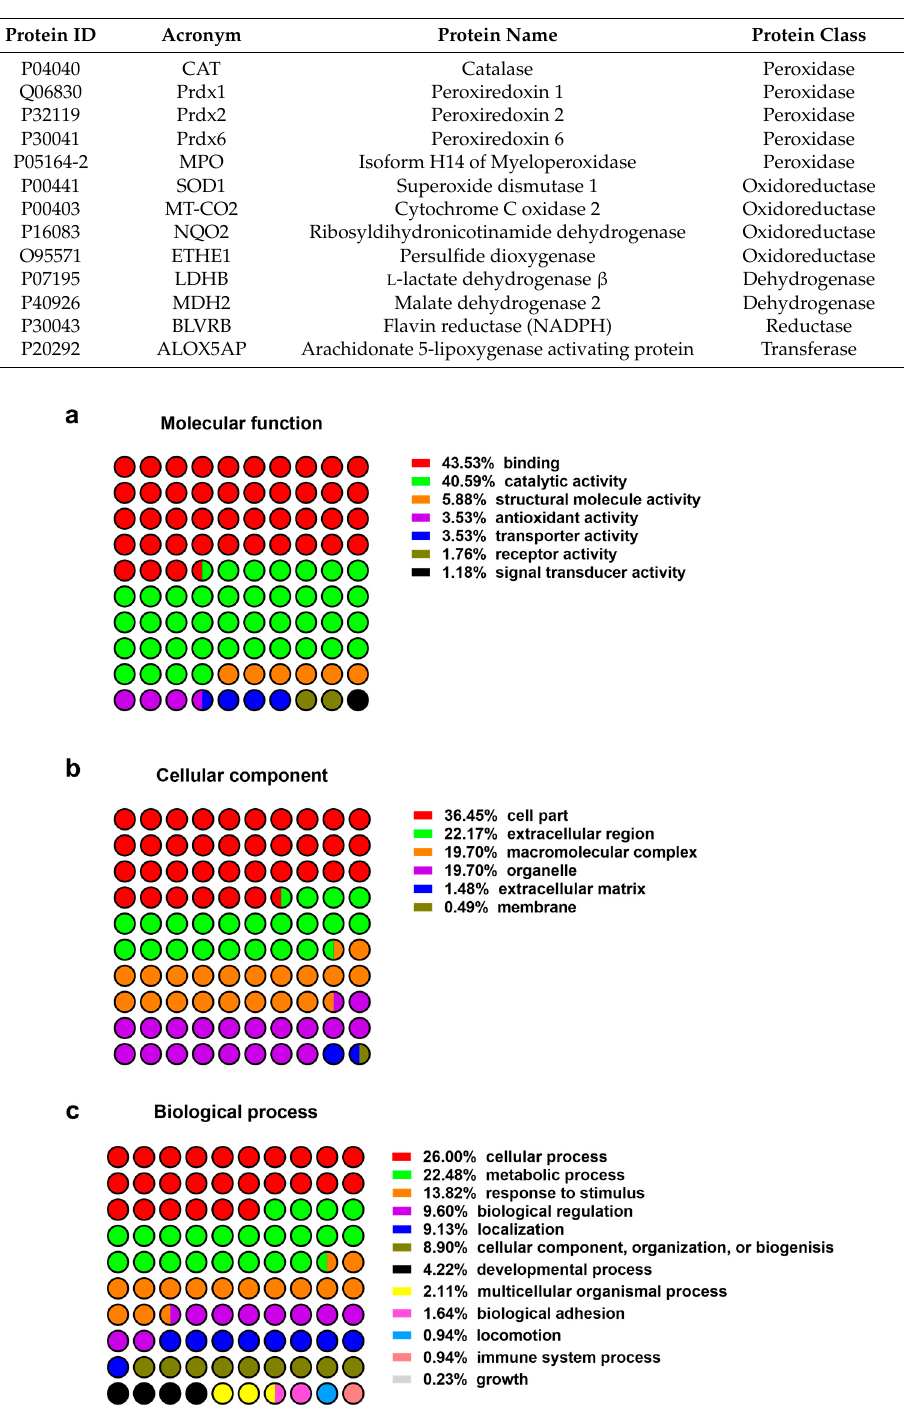
Figure 1. Protein classification: ( a ) Molecular function; ( b ) cellular compartment; ( c ) biological process.